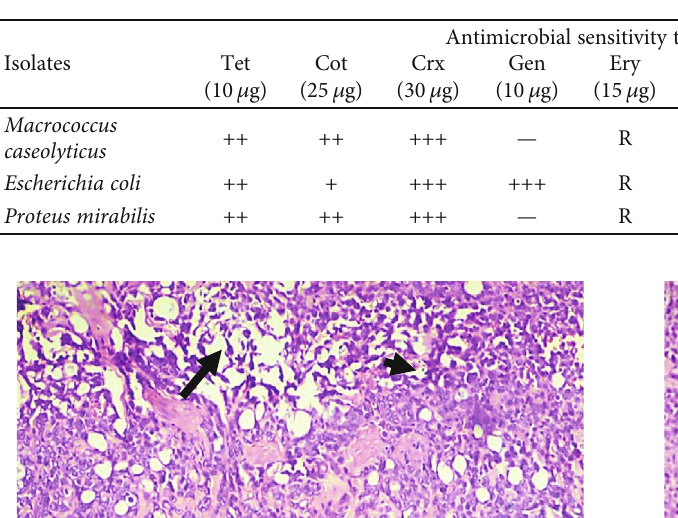
Table 3: Bacterial culture and identi fi cation test results.